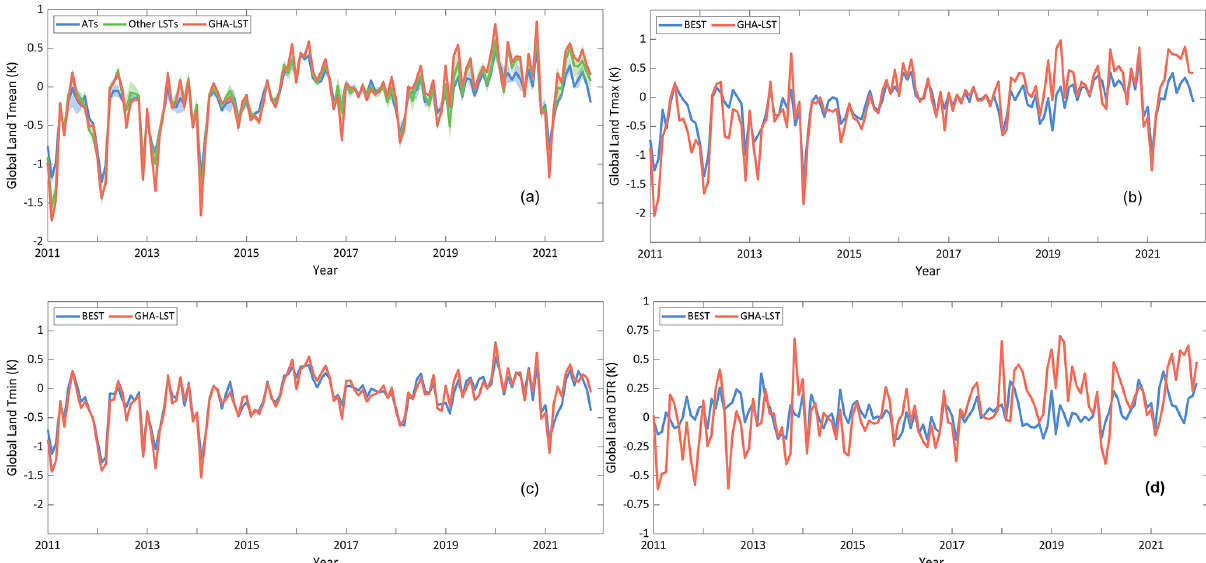
Figure 10. Monthly anomaly variation in the globally geographically weighted LST and land surface air temperature (AT) at different scales: (a) mean temperature ( T mean ), (b) maximum temperature ( T max ), (c) minimum temperature ( T min ), and (d) diurnal temperature range (DTR). The abbreviations used in the figure are as follows: GHA-LST – global hourly, 5km, all-sky land surface temperature and BEST – Berkeley Earth Surface Temperatures.